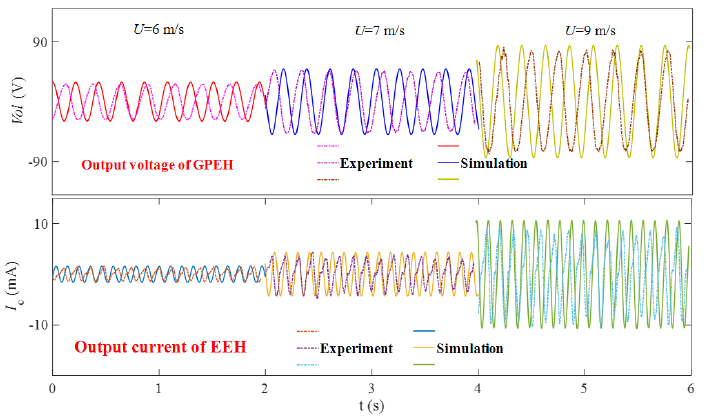
Figure 14. Comparison of time-domain diagram of experimental results and numerical analysis results of the output performance of GPEEH at 6, 7, 9 m/s.